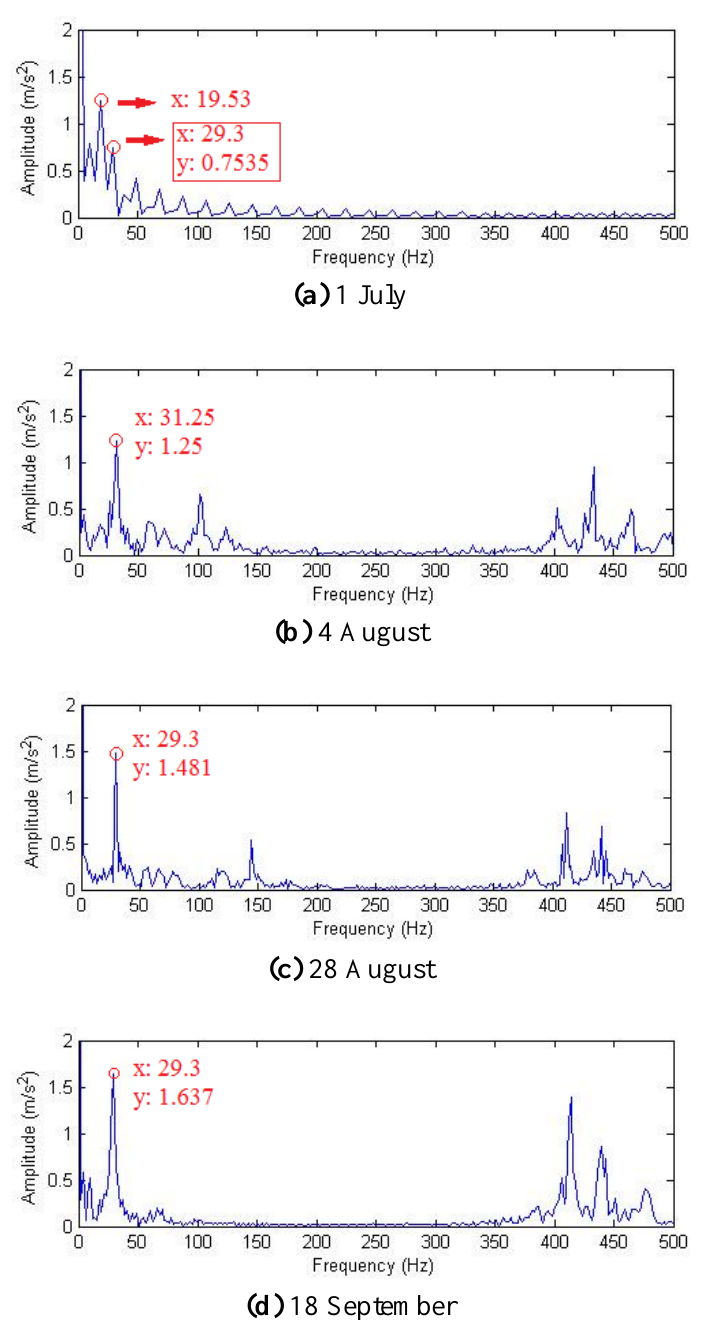
Figure 19. Demodulation spectra with composite dictionary multi-atoms